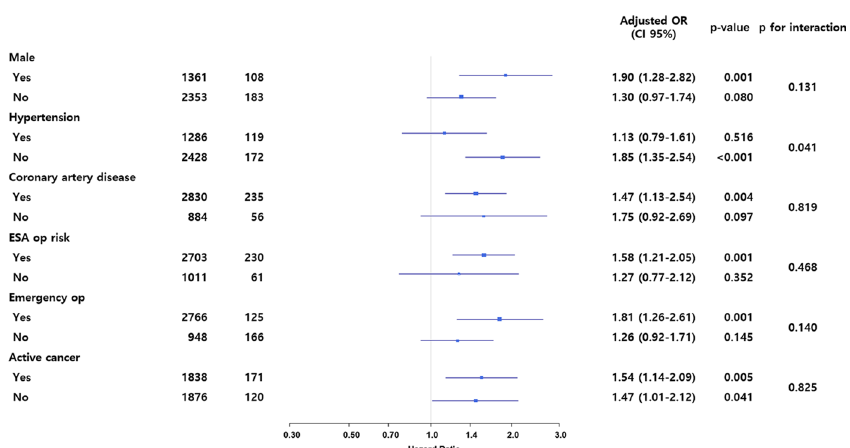
Figure 4. A forest plot based on subgroup